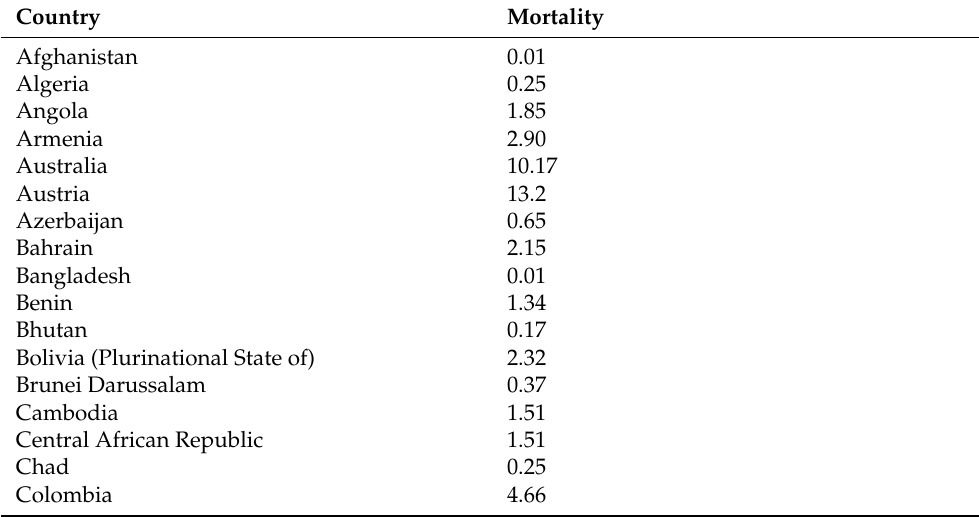
Table A1. Alcohol-related mortality rates in selected countries in